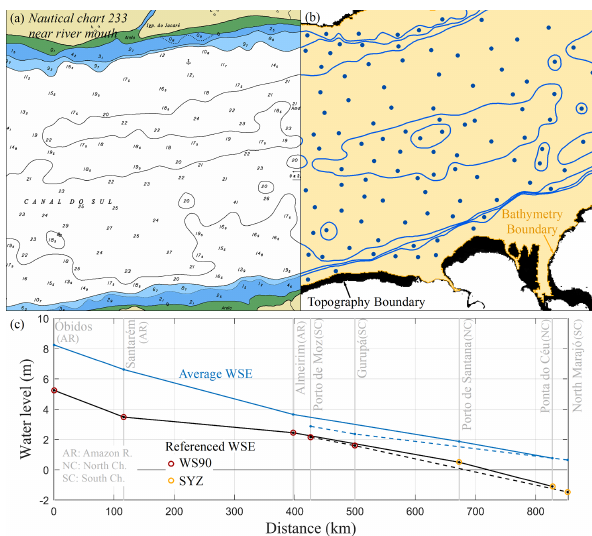
Figure 2. (a) Example of a nautical chart near the river mouth (code 233). (b) Digitized pointwise soundings and isobaths, along with bathymetric boundaries (defined as the 96% isoline of flood fre- quency) and topographic boundaries (defined as the 0% isoline of flood frequency); the two regions are immediately adjacent. (c) Ref- erenced WSE (black lines) and average WSE (blue lines) along the Amazon estuary (EGM08